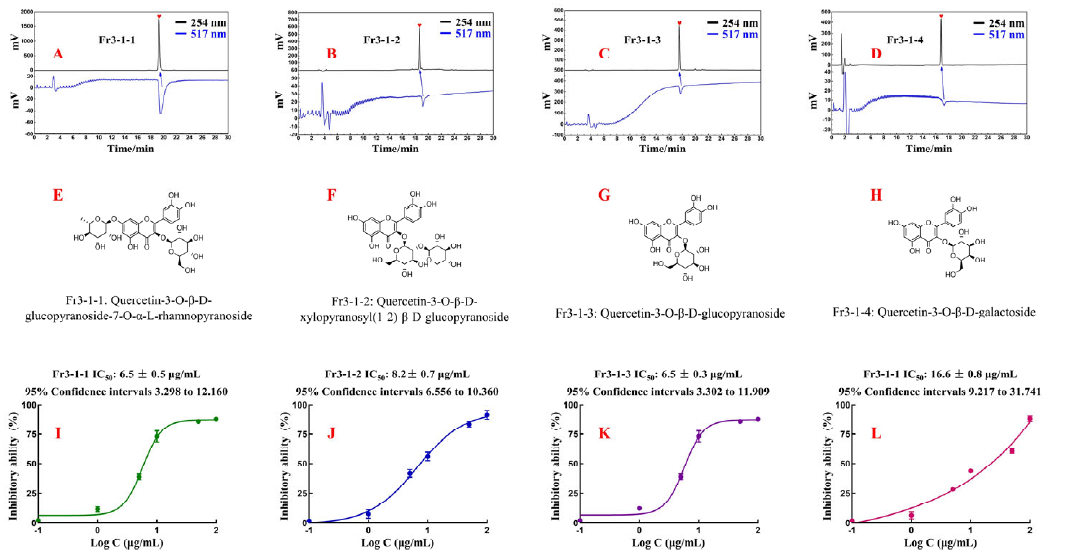
Figure 6. ( A – D ) Activity verification chromatograms of Fr3 ‐ 1 ‐ 1, Fr3 ‐ 1 ‐ 2, Fr3 ‐ 1 ‐ 3, and Fr3 ‐ 1 ‐ 4. ( E – H ) Chemical structures and names of Fr3 ‐ 1 ‐ 1, Fr3 ‐ 1 ‐ 2, Fr3 ‐ 1 ‐ 3, and Fr3 ‐ 1 ‐ 4. ( I – L ) DPPH clearance curves of Fr3 ‐ 1 ‐ 1, Fr3 ‐ 1 ‐ 2, Fr3 ‐ 1 ‐ 3, and Fr3 ‐ 1 ‐ 4.